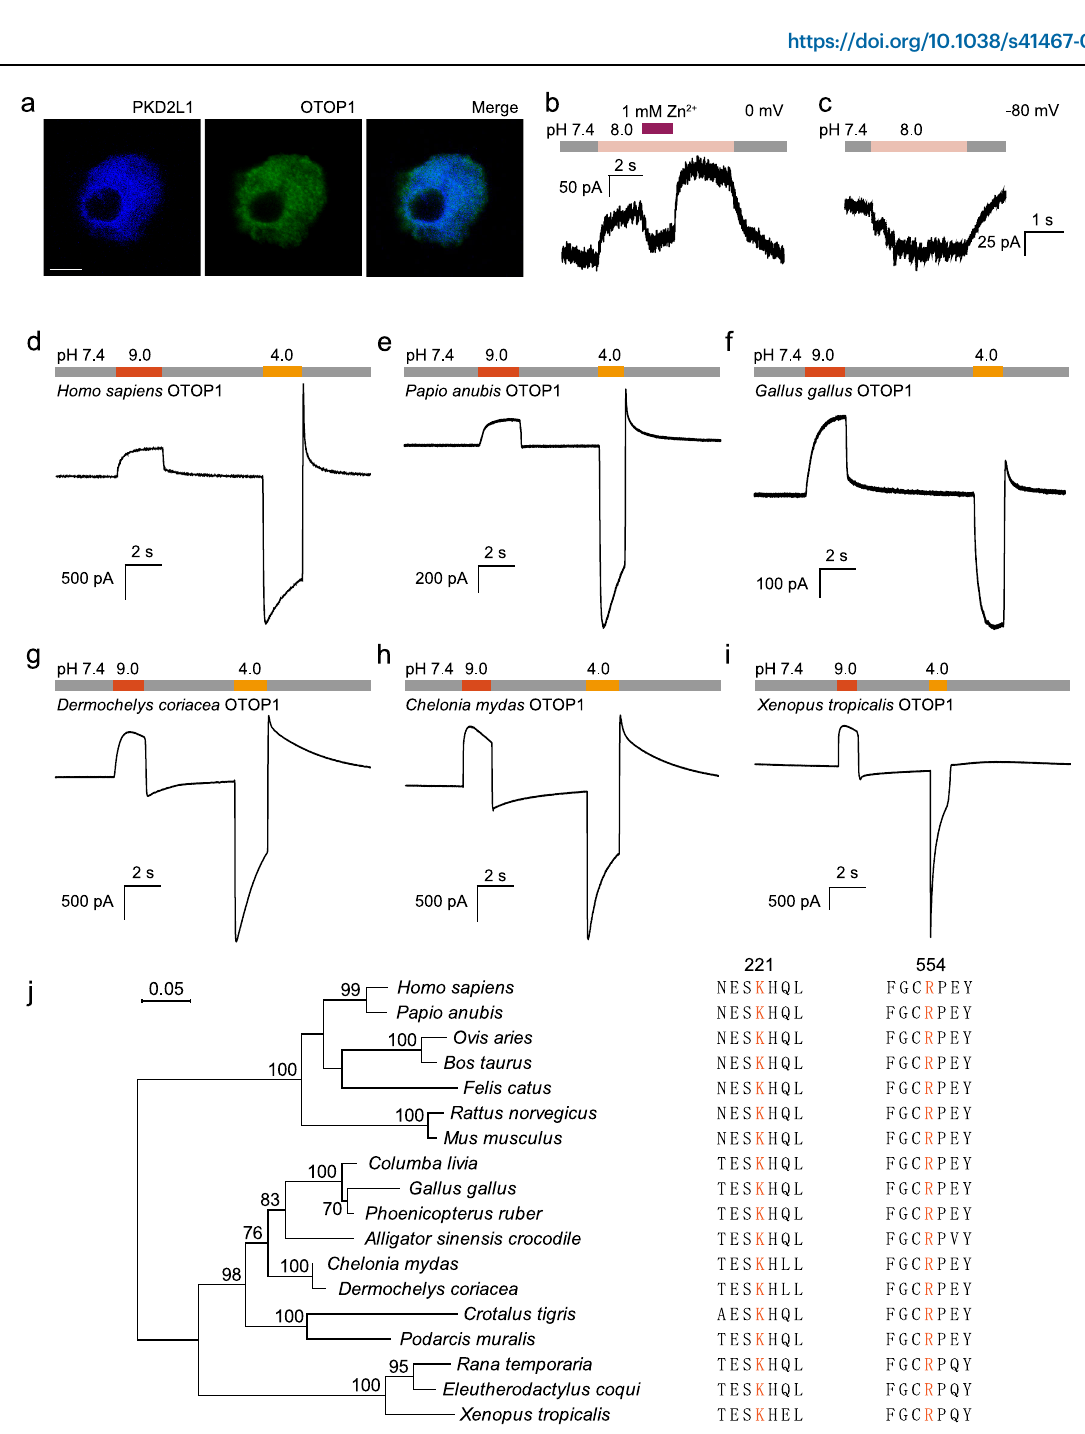
indicated), with holding and test voltages both set to 0mV. j Maximum-likelihood phylogenetic tree created from multiple sequence alignment of OTOP1 channel proteins in vertebrates (left). Bootstrap values of branches are marked on nodes, the number of bootstraps was 1000. The scale bar (top, left) indicates 0.05 amino acid substitutions per site. Alignment of amino acid sequences of OTOP1 in ver- tebrates. Key residues associated with alkali binding are shown in orange (right). Source data are provided as a Source Data fi